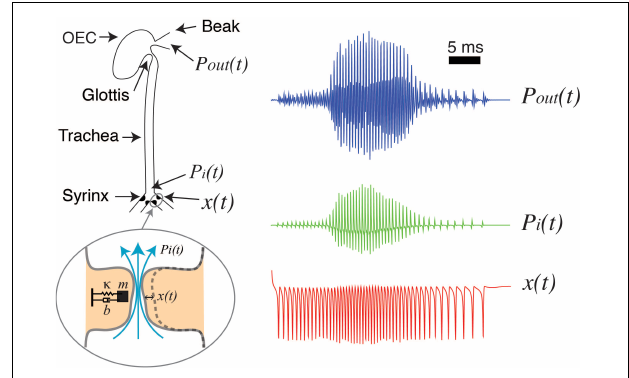
FIGURE 1 | Schematized view of the sound source and vocal tract of songbirds, and its filtering effects. The syringeal membrane modeled as a mass ( m ) with damping ( b ) and a restitution force ( k ), is able to display auto-sustained oscillations when nonlinear functions representing a flapping movement of the labia are introduced. These oscillations are the sound source [x(t), red line, representing the medial position of a labium] as pressure variations are generated at the input of the trachea [P i (t), green line], and then filtered by the oro-esopharingeal cavity (OEC). The output of the dynamical model is the pressure [P out (t), blue line] that will result in the synthetic sound (see text for further details). Adapted from Amador et al.